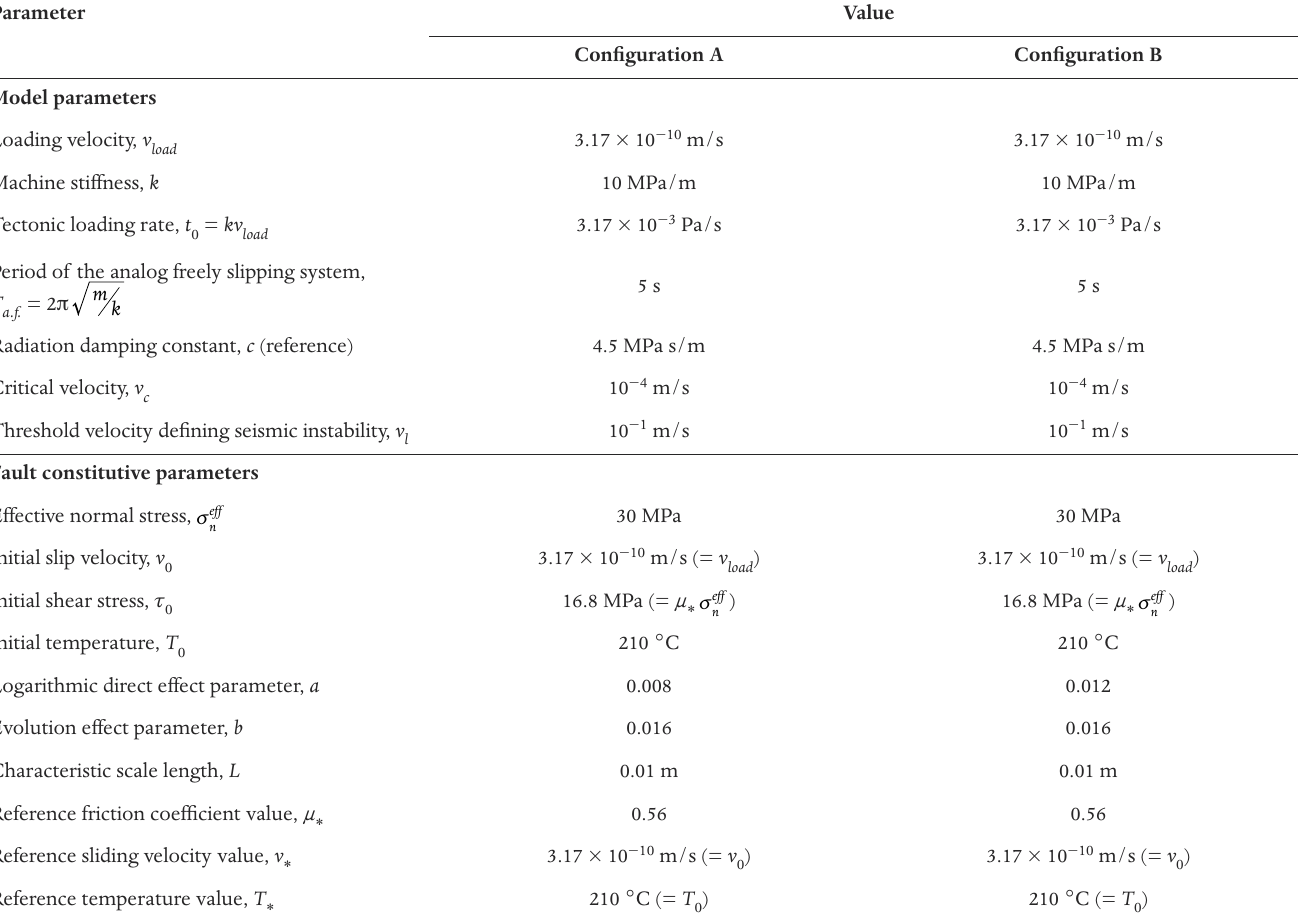
Table 1. Parameters adopted in the present study. Both configurations are velocity weakening regimes, but Configuration A (with b = 2 a ) represents a more unstable fault with respect to Configuration B. Next page. / Top: Figure 1. Comparisons between the numerical simulations for the DR law (Equation 5) without and with the RDT (thick and thin lines, respectively). (a) Time evolution of displacement. (b) Slip velocity history on a logarithmic scale. (c) Time history of the temperature developed by frictional heating, computed as in Equation (3) by Bizzarri [2010c], which is known to represent an upper bounds of the frictional heating. D T represents the difference between the temperature computed at the present time step and the initial temperature, which in this case also equals the reference temperature (see Table 1). (d) Phase diagram; i.e., normalized stress versus dimensionless slip velocity. The quantity A is defined as A = a . The vertical black line represents / v ), which is the threshold between the quasi-static and the full dynamic regimes (see Section 2.3 for numerical details). The parameters are listed ln( v c * in Table 1. Red curves, Configuration A; blue curves, Configuration B. /Bottom: Figure 2. As for Figure 1, here related to the RD law (Equation 6).